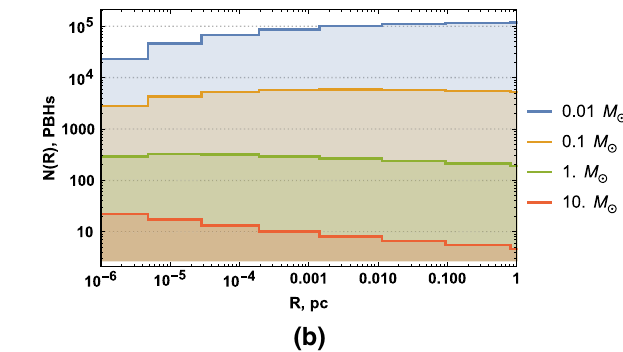
(at z ∼ 10 4 ). Characteristic cluster radius is ∼ 1 pc. After detachment, the central region appears to be more dense (though it is not clearly seen in the figure) while the total number of the PBHs inside the cluster remains almost the same